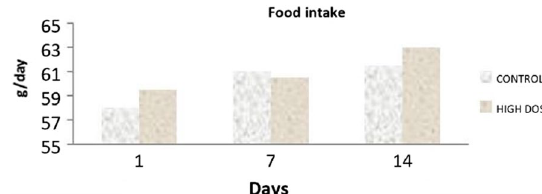
Fig. 4 Change in food (g/day) of the animals exposed to TRV